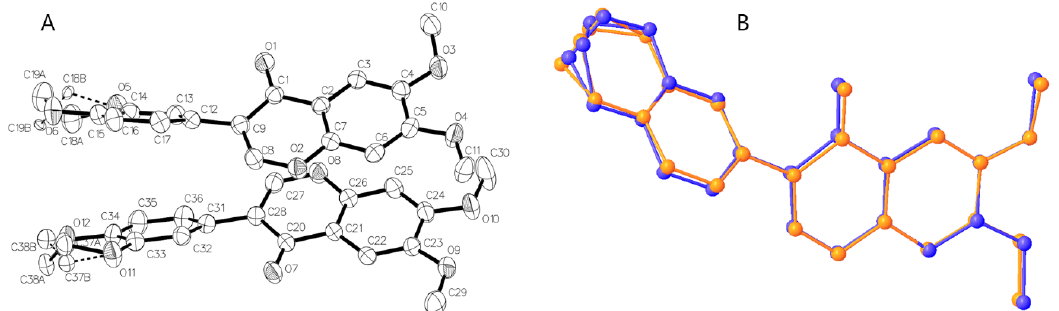
Figure 1. ( A ) Molecular structure of the title compound 5 with atomic labelling. The asymmetric part of the unit cell incorporates two independent molecules 5I (C1–C19) and 5II (C20–C38). Displacement ellipsoids are drawn at the 30% probability level. The minor component of the disordered moiety is drawn with open bonds. ( B ) An overlay diagram of two independent crystals 5I (orange color) and 5II (blue color) of title compound 5 . H atoms are omitted for clarity.